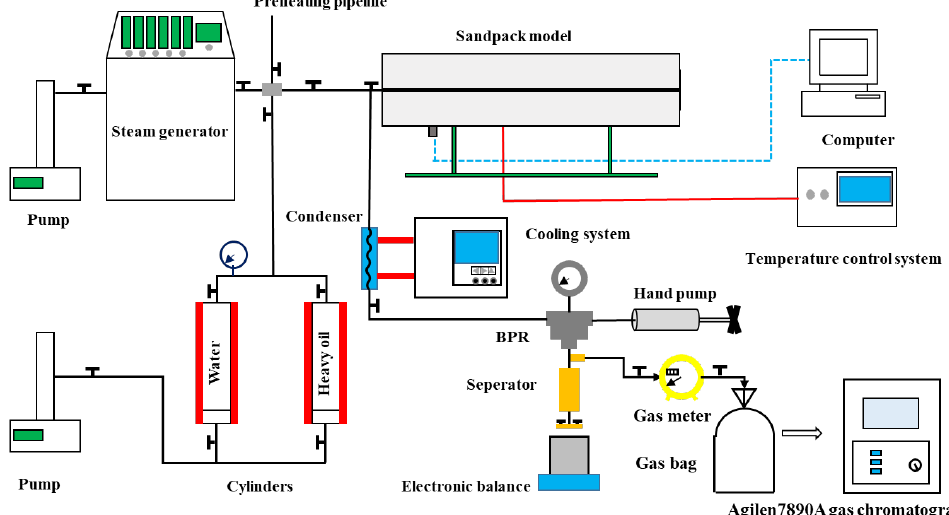
Figure 2. Schematic illustration of the experimental setup for one-dimensional CSS experiment.